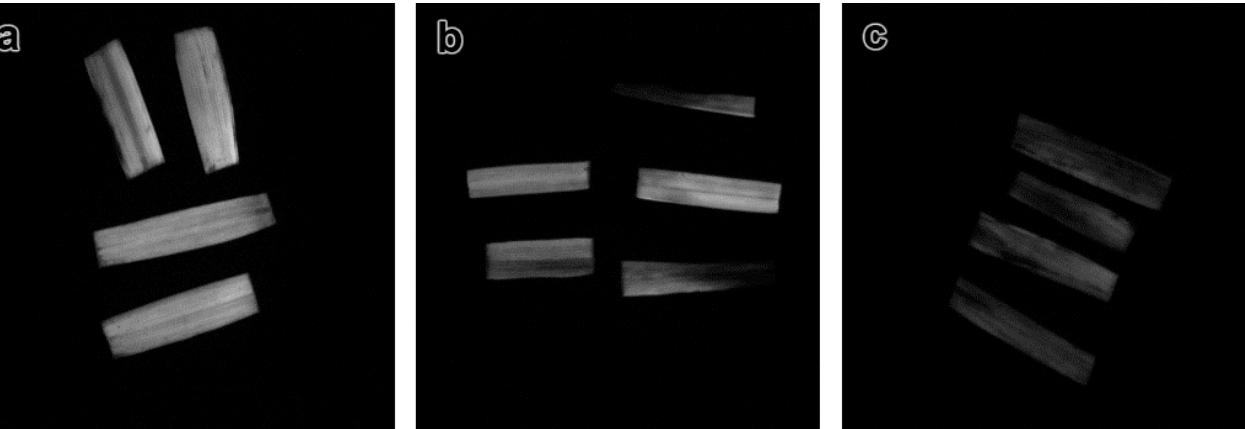
and R fd 2000 = 0.16 ± 0.02 at p = 0.05, n = 8 .